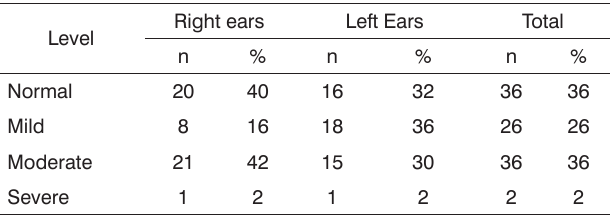
Table 4. Audiometric test results for right and left ears; patients in the diabetes mellitus group, according to hearing loss level - Davis & Silvermann 24 .